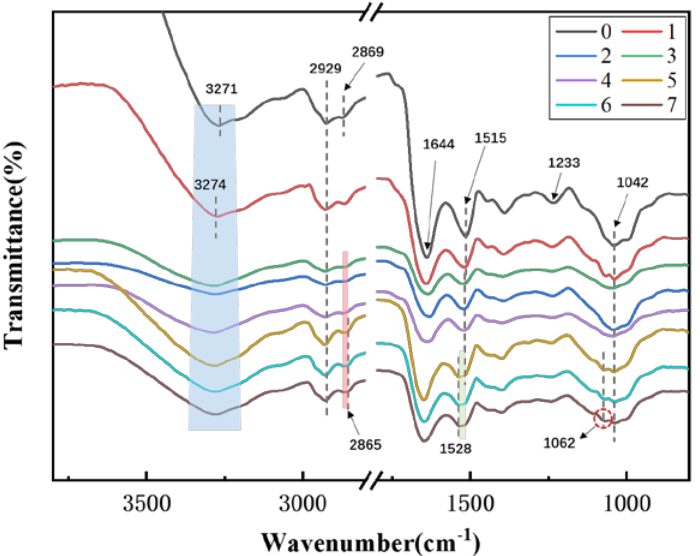
Figure 1. ATR-FTIR spectra of pristine soybean meal (0) and investigated adhesives (1–7).